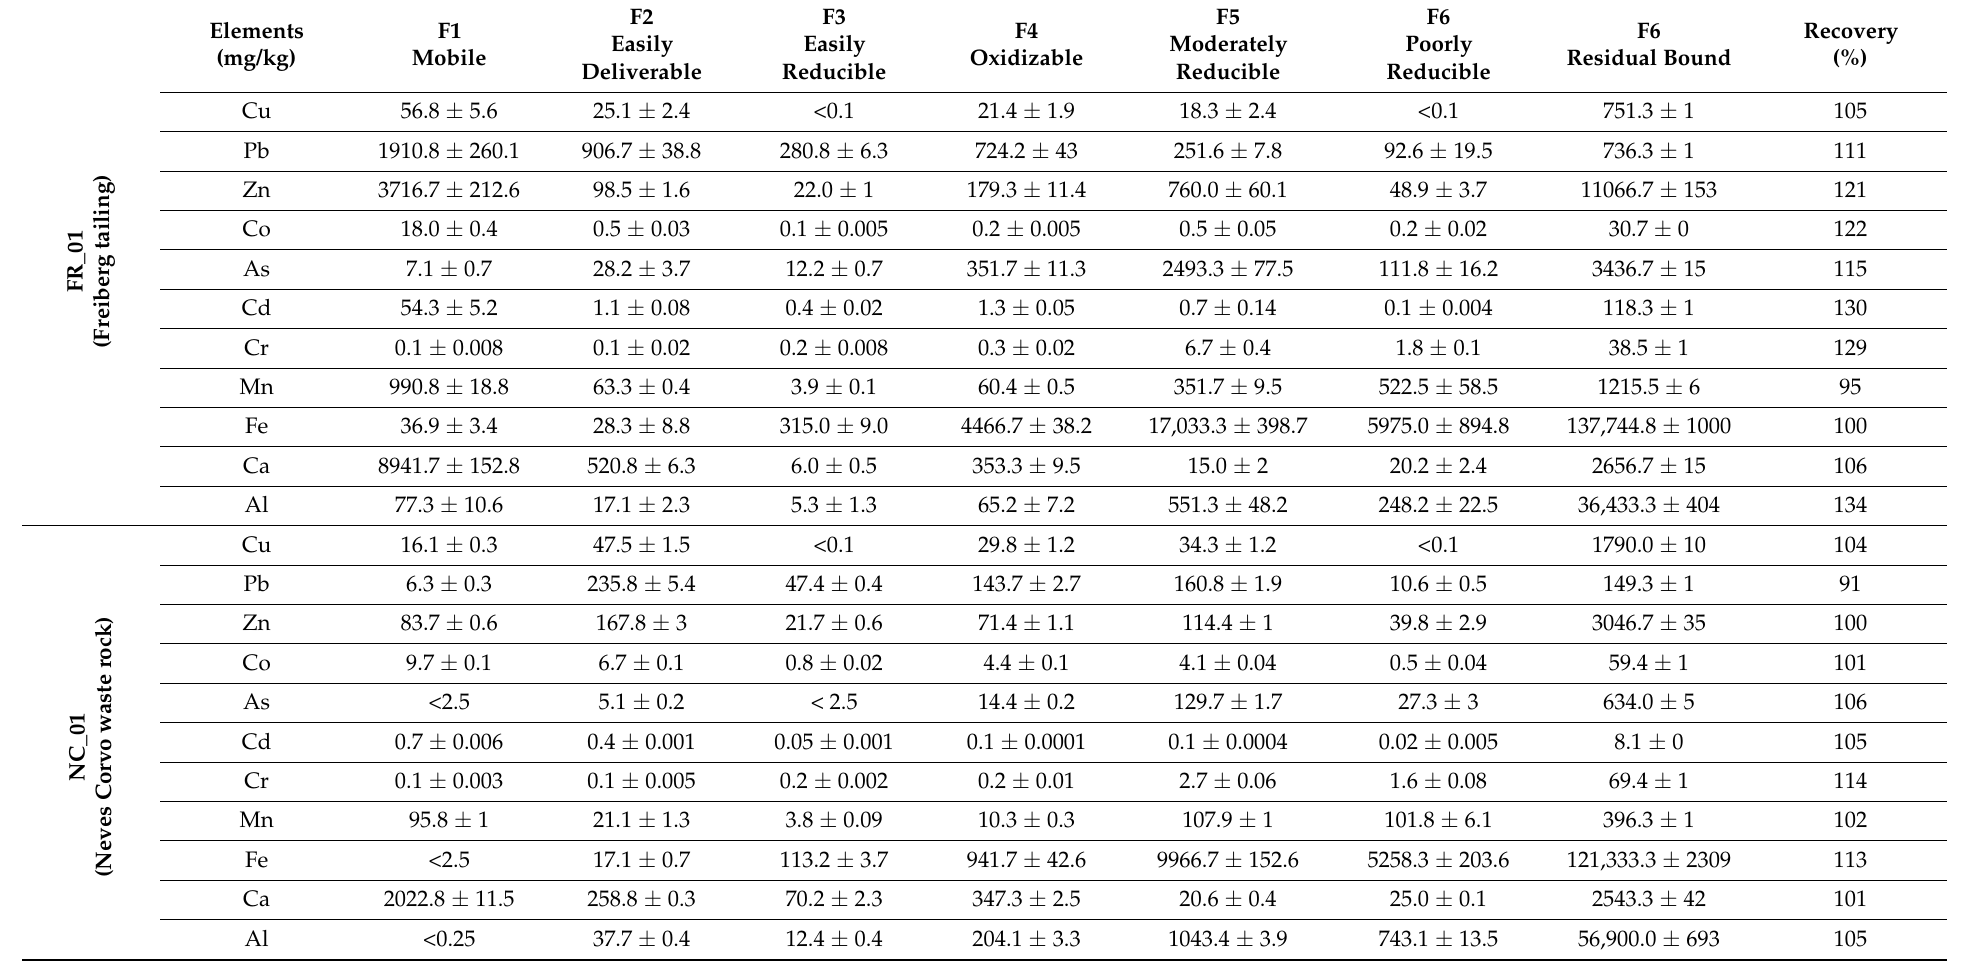
Table 4. Fractionation of metal(loid)s (concentration in mg/kg) in operationally defined fractions using Zeien and Brummer’s sequential extraction scheme for one waste sample originating from the Freiberg mine and two from the Neves Corvo